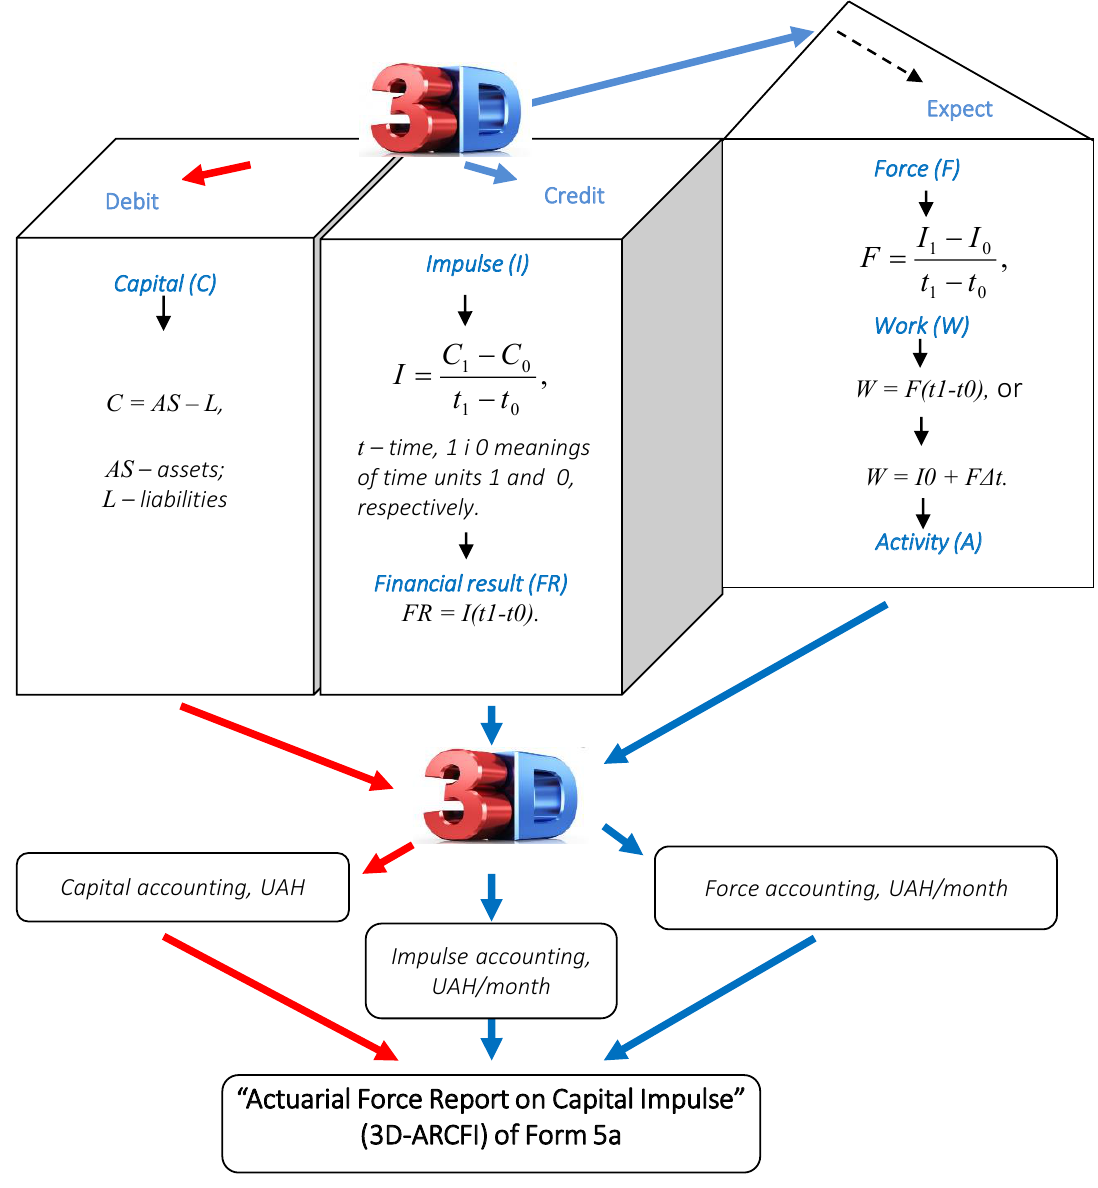
Figure 1. Rationale for the construction of 3D actuarial force accounts in the system of 3D